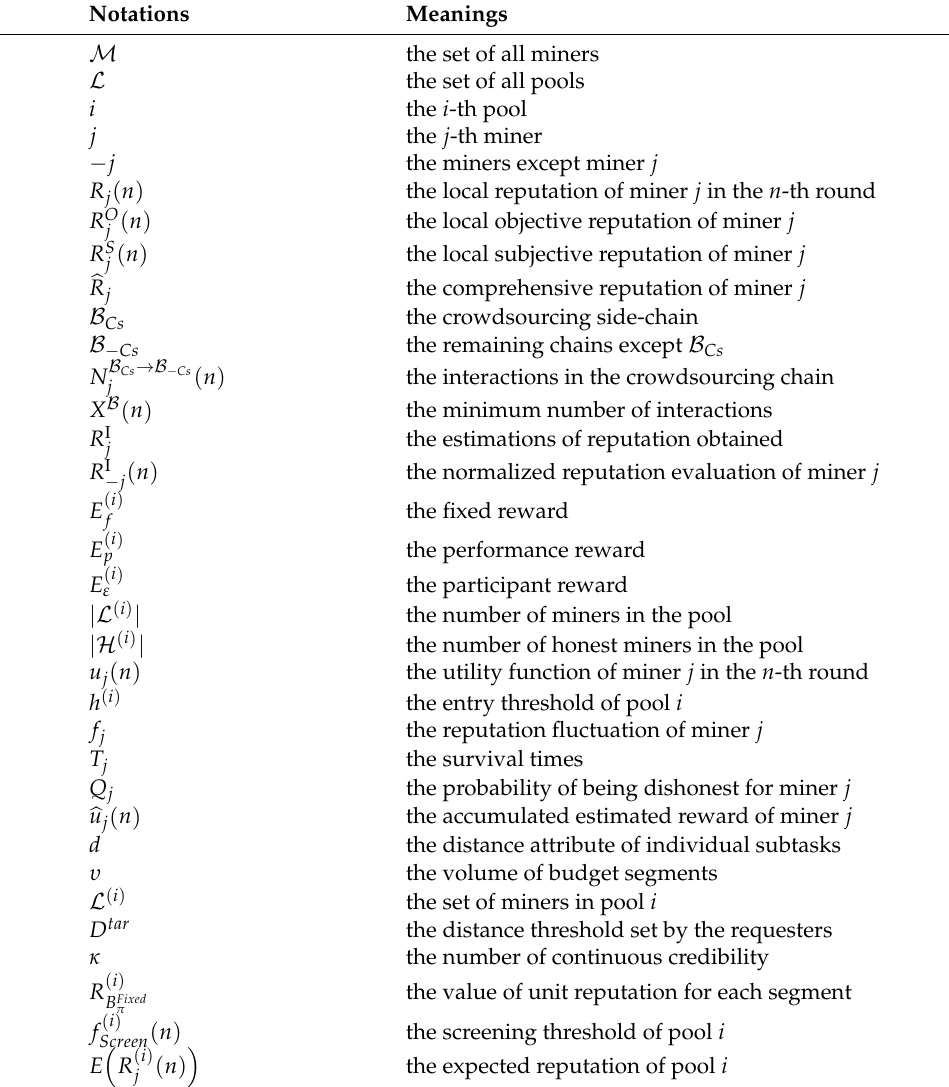
Table 1. Summary of the key